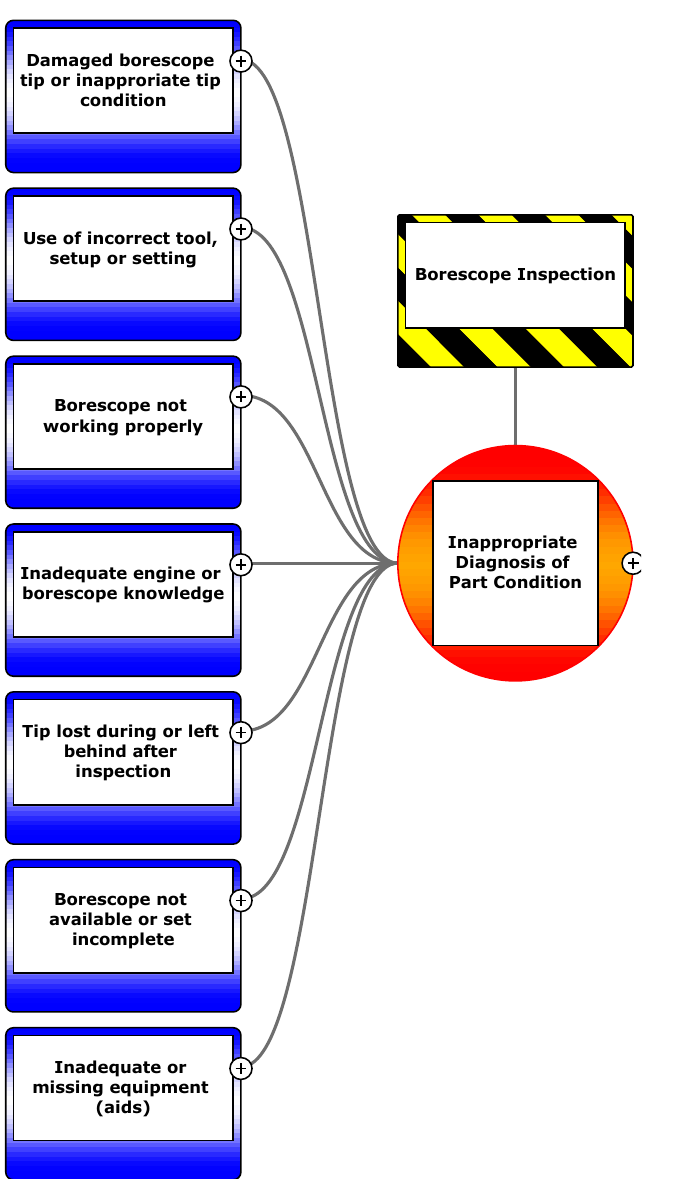
Figure 5. Bowtie diagram for “inappropriate diagnosis of part condition” with threats.